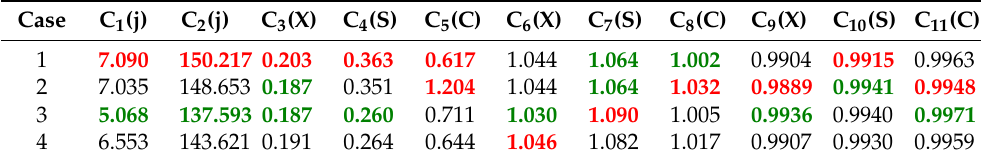
Table 9. Values for the criteria by a different case.